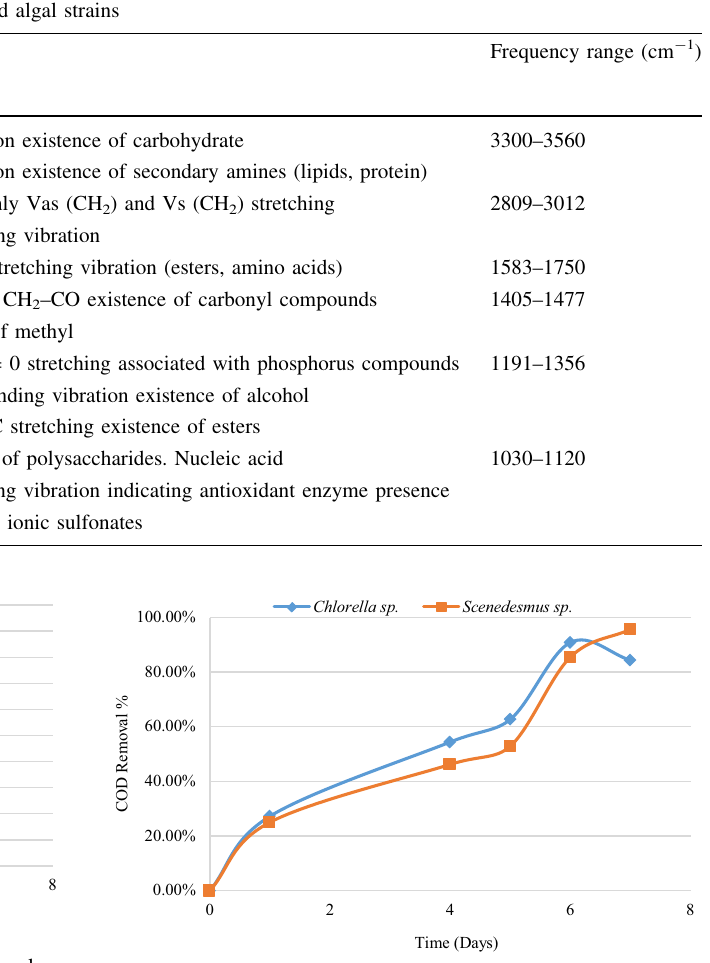
Fig. 7 Percentage removal of COD vs